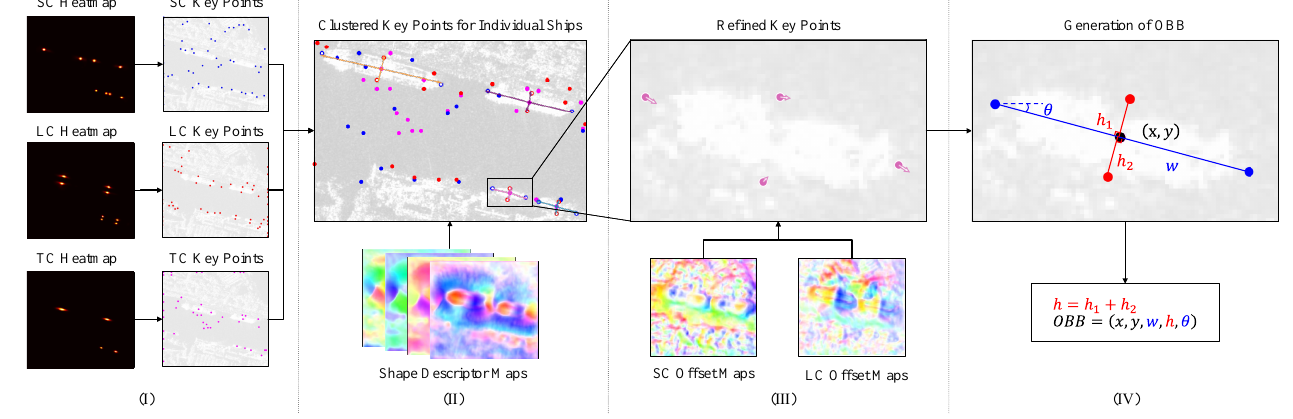
Figure 7. The proposed decoding pipeline and its four steps: ( I ) key point detection, ( II ) key point clustering, ( III ) refinement of key points, and ( IV ) OBB generation. The SAR image is brightened to clearly see the overlaid detection results. The shape descriptor and offset maps are encoded in the HSV (Hue, Saturation, Value) color space, where H encodes the orientation of the offset, S encodes the length of the offset, and V is set to a constant value of 255. The 8-channel shape descriptor heatmap is shown as four maps corresponding to the four